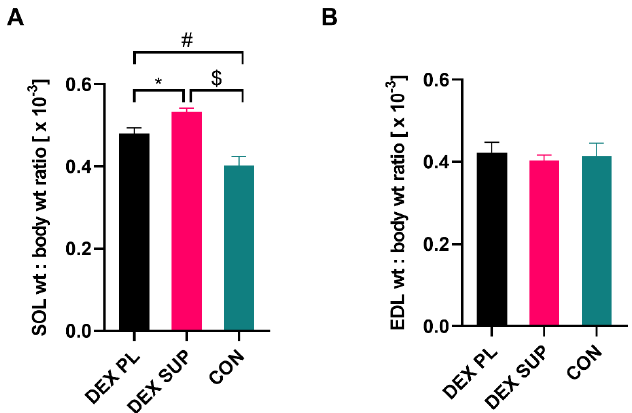
Figure 6. Mean muscle weight: body weights ratio in DEX-treated rats in SOL ( A ), and EDL ( B ). Results are expressed as mean ± SEM. DEX PL ( n = 7), DEX SUP ( n = 8), CON ( n = 6), * p < 0.05, # p < 0.01, $ p < 0.0001. DEX PL: dexamethasone-treated group supplemented with placebo; DEX SUP: dexamethasone-treated group supplemented with vitamin D 3 ; CON: control group; EDL: extensor digitorum longus; SOL: soleus.